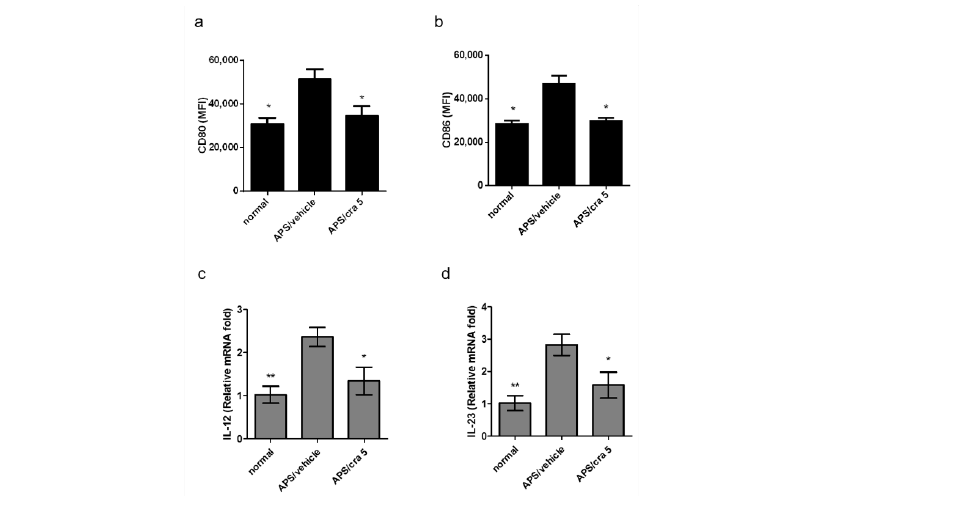
Figure 8. Effects of carssolide on the expression of surface markers of splenic DCs in APS mice. Spleen cells were purified from different mouse groups on day 56, and the relative mean fluorescence intensity (MFI) of ( a ) CD80 and ( b ) CD86 were measured by flow cytometry. Data are presented as mean ± SEM of 5 mice from one of three independent experiments. ( c ) IL-12 and ( d ) IL-23 mRNA expression levels in purified splenic CD11c+DCs determined by reverse transcription-quantitative PCR. Data were normalized to hypoxanthine guanine phosphoribosyl transferase 1 expression levels. * p < 0.05, ** p < 0.01, versus vehicle-treated APS mice group, tested by one way ANOVA followed by Tukey’s multiple comparison test.